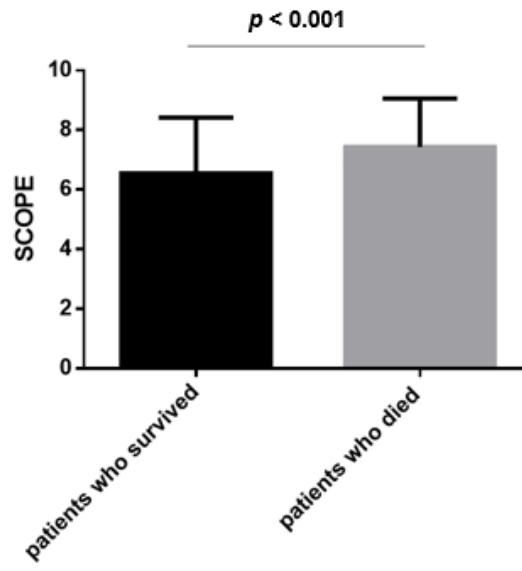
An amount of 70 (26.1%) of patients died in the ICU. Patients who died had higher mSCOPE score compared to patients who survived [8 (6, 9) vs. 7 (5, 8), p < 0.001, respec- tively]. (Figure 3). Figure 3. SCOPE according to the patient’s outcome.